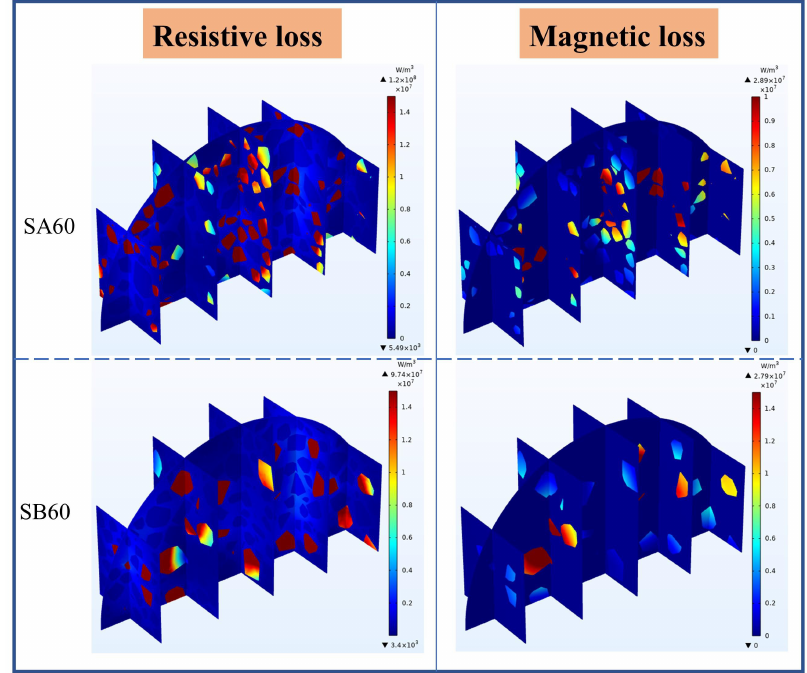
Figure 8. The multi-sections of the heat source distribution of SA60 and SB60.